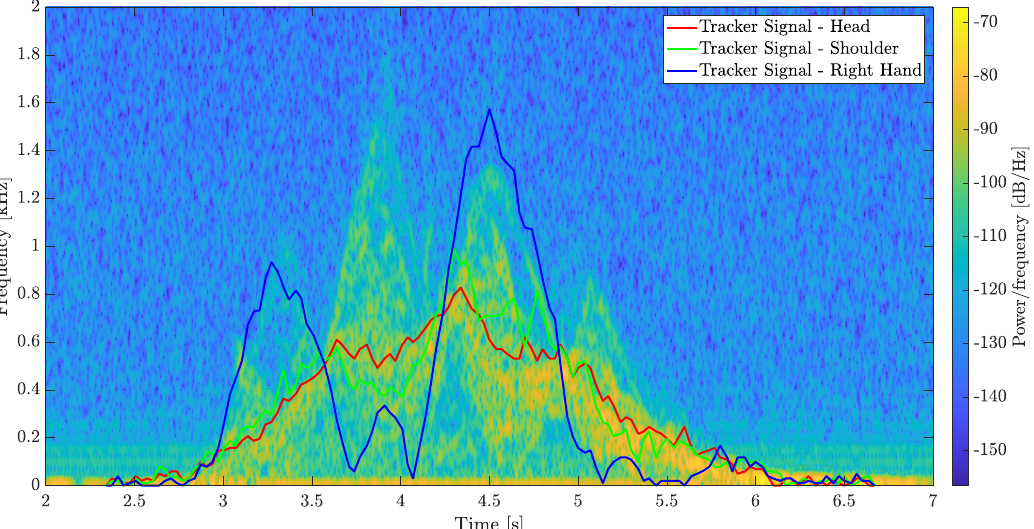
Figure 12. Presentation of the measurement results for a walking man. The spectral signature was measured using the MMW radar, and the colored lines indicate the data obtained through tracking the subject’s head, shoulder and right hand in a recorded